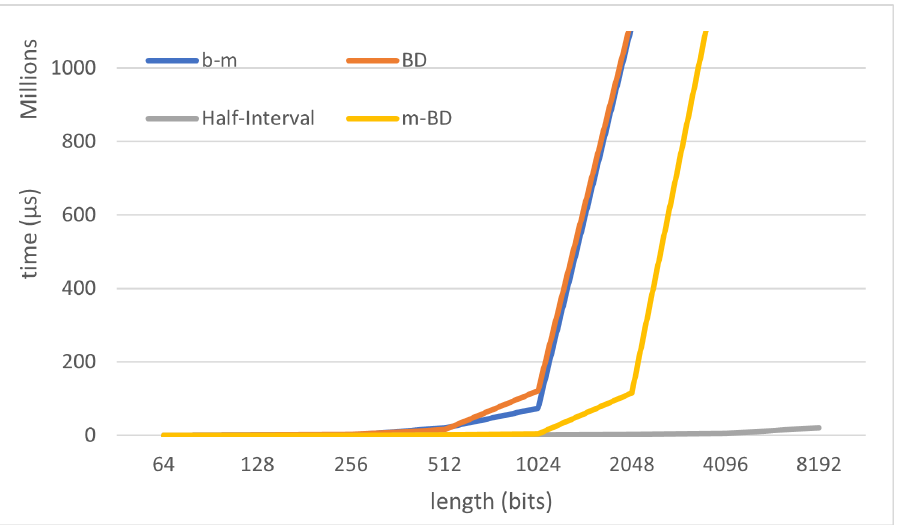
Figure 5. Comparison between the algorithms in the LC calculation for all the possible GSS-sequences of a given length (m-BD